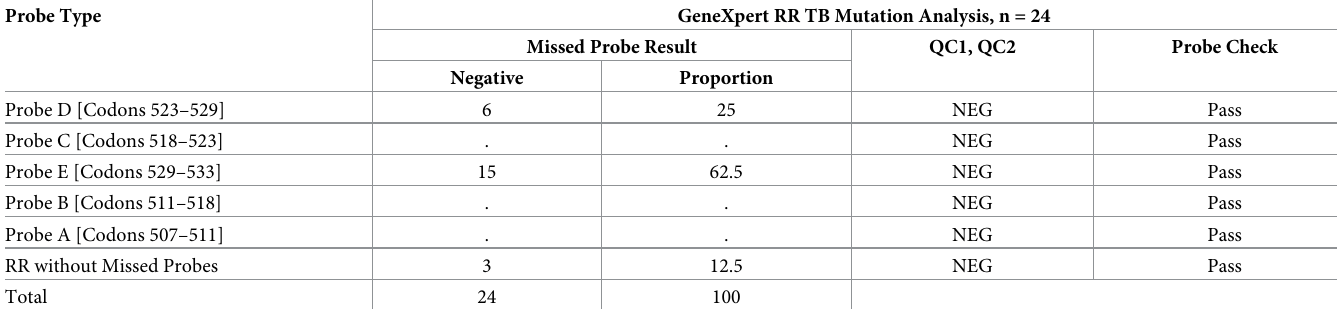
Table 3. The proportion of mutations conferring RR-TB detected in the RRDR in Addis Ababa from October 2019 to March 2020.